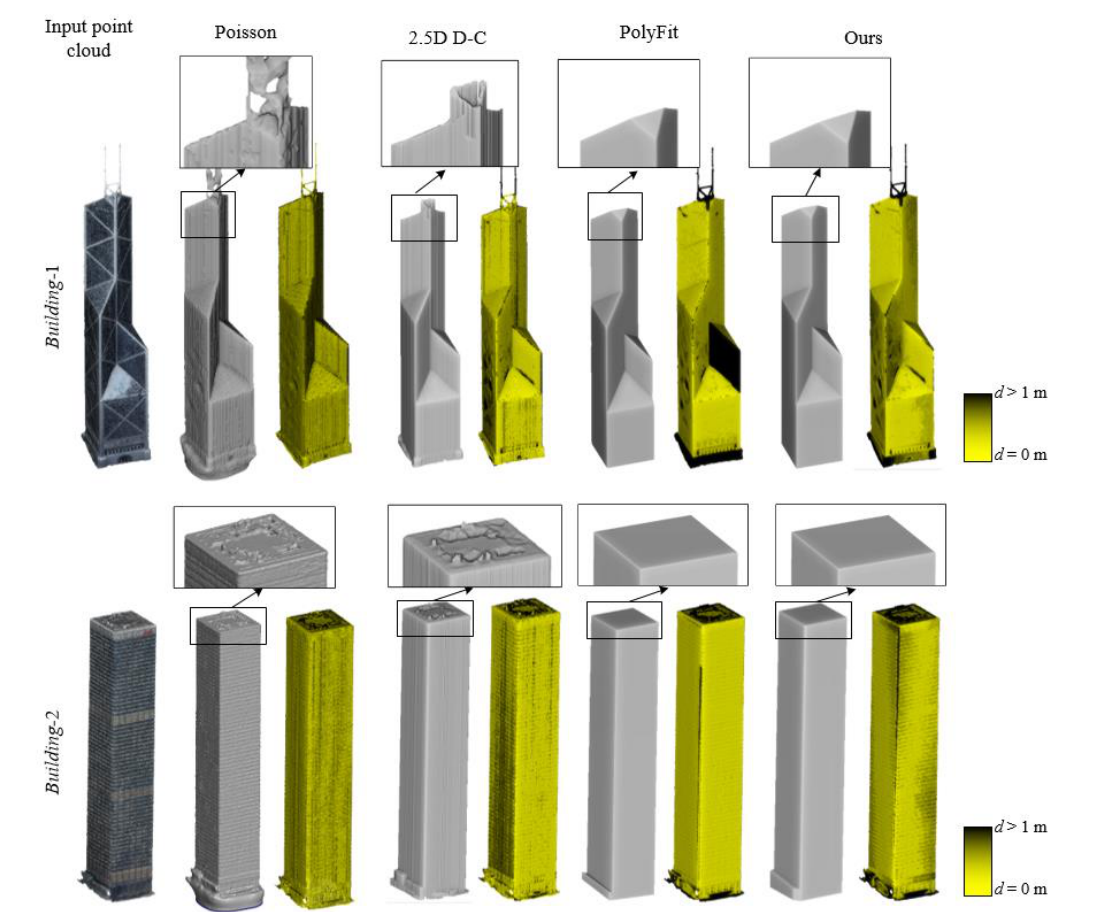
Figure 9. Evaluations of reconstruction results of two simple buildings and comparison with the results of Poisson, 2.5D D-C and PolyFit. Details of the reconstructed building rooftops are shown in the black rectangles, where the input point clouds are overlapped on the building